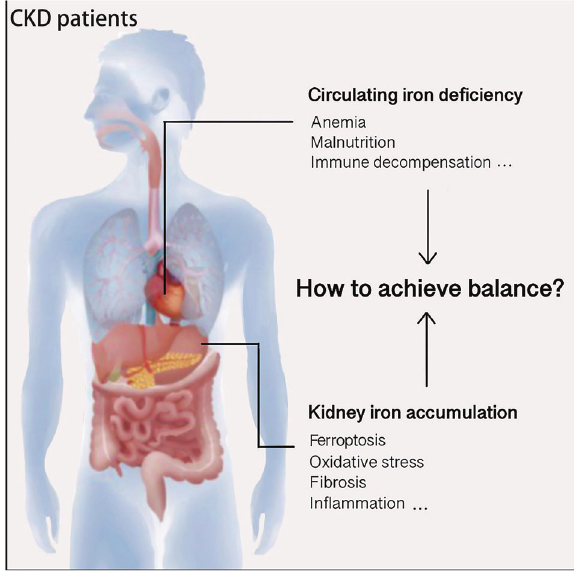
Fig. 8 Opposite iron status in the kidney and blood circulation of patients with